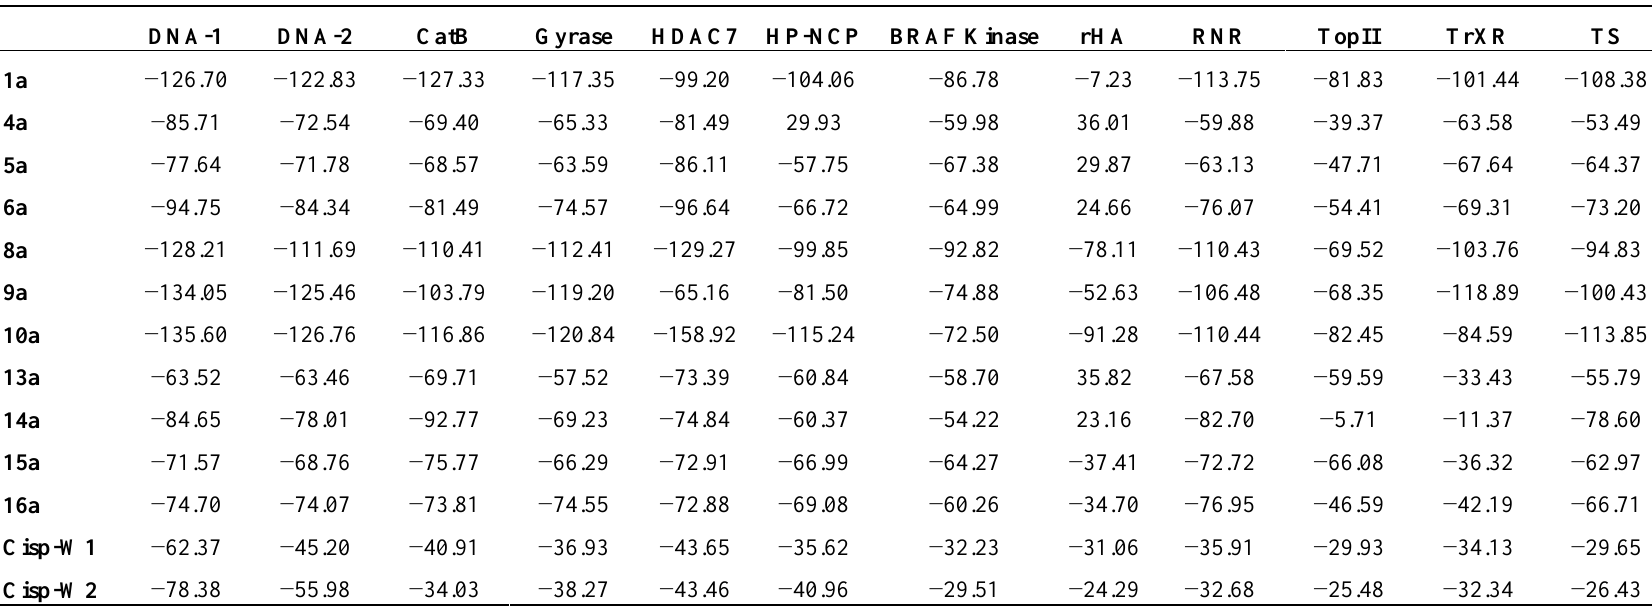
Table 7. The binding affinities of the metallocompounds from the covalent constrained Molegro docking of hydrated complexes.